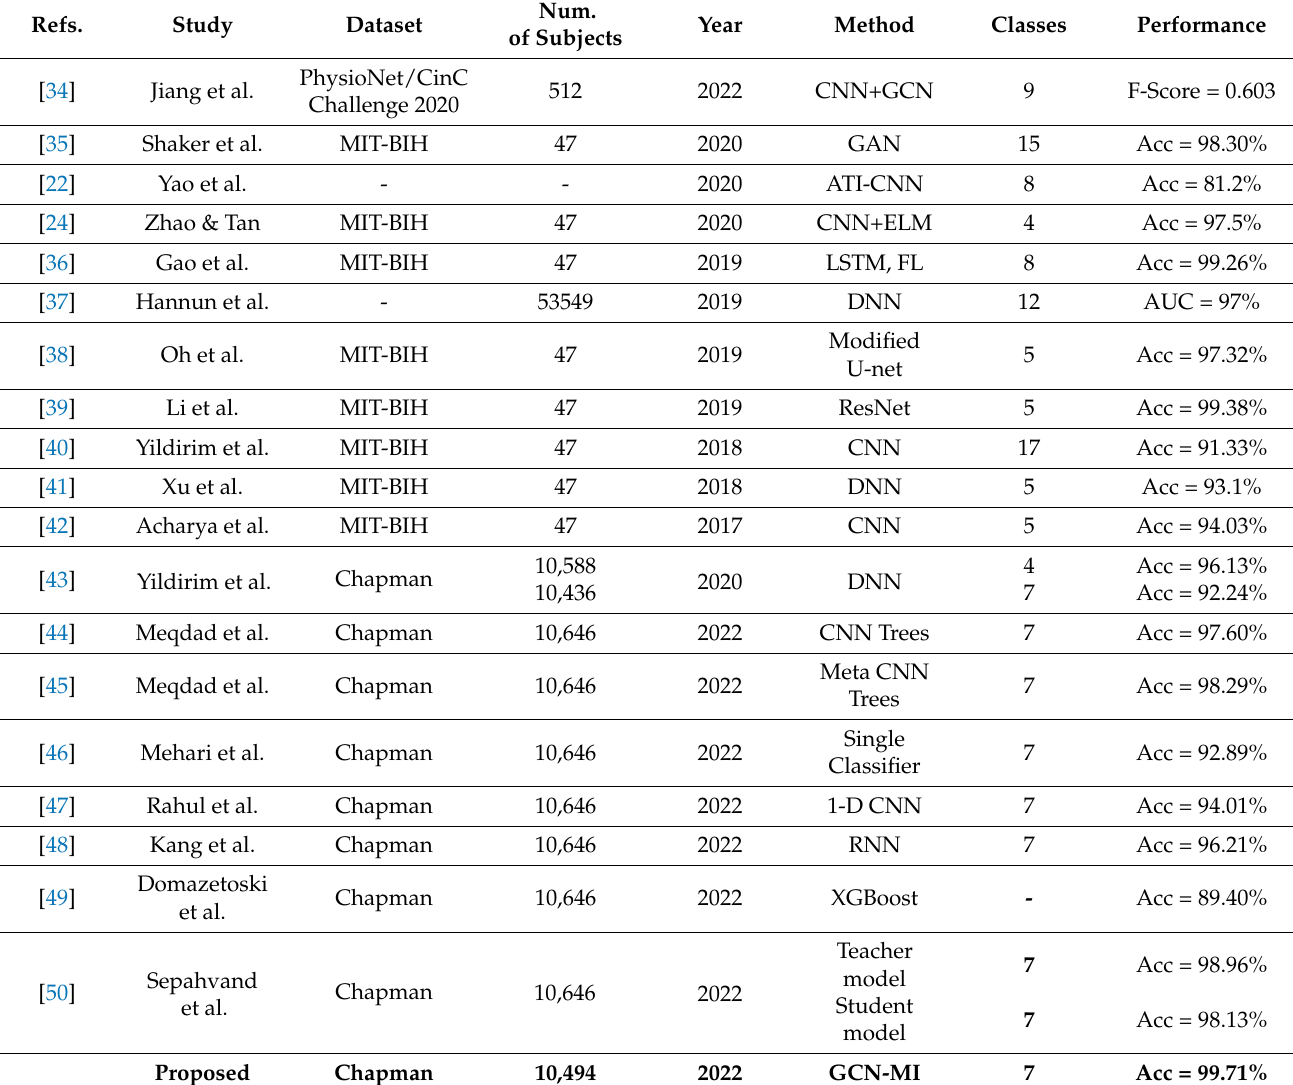
Table 5. Performance comparison of the proposed method with other state-of-the-art methods.